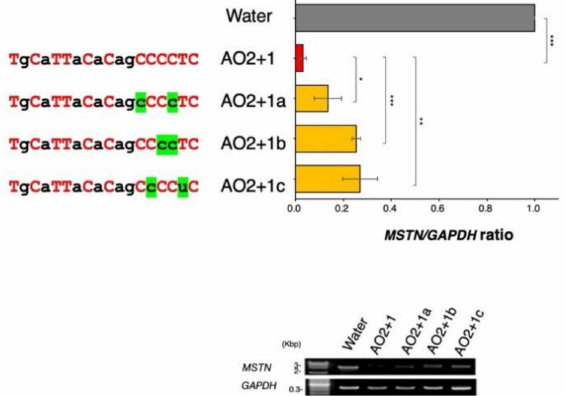
Figure 4. Identification of the best chimeric ASO structure. AO2+1 comprised 12 ENA and 6 2 (cid:48) -OMe RNA components. To find the most effective structure of AO2+1, AO2+1 was modified by replacing ENA with 2 (cid:48) -OMe RNA. Ultimately, three derivatives of AO2+1 were synthesized (AO2+1a, AO2+1b, and AO2+1c). The sequences of these ASOs are described in the top left panel. Red uppercase and black lowercase letters represent ENA and 2 (cid:48) -OMe RNA, respectively. Green marking of 2 (cid:48) -OMe RNA indicates the replaced nucleotide. These ASOs were examined for their ability to inhibit the production of mature MSTN mRNA in CRL-2061 cells by RT–PCR amplification (bottom). The amount of product was calculated and is expressed as the ratio of MSTN to GAPDH . The MSTN / GAPDH ratio was lowest in AO2+1-treated cells. * = p < 0.05, ** = p < 0.01, *** = p < 0.001 vs. AO2+1